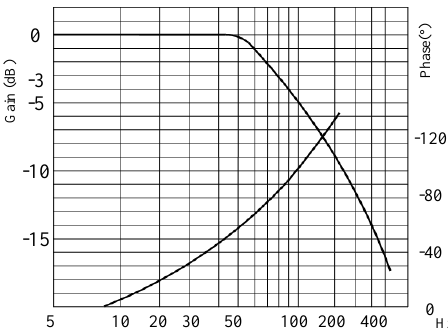
Figure 4. Frequency response of CSDY-I type jet pipe electro-hydraulic servo valve.